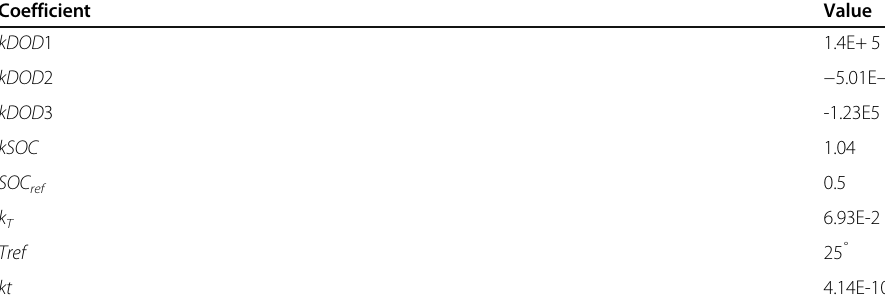
Table 2 Constant coefficients of the battery degradation model (Xu et al., 2016)